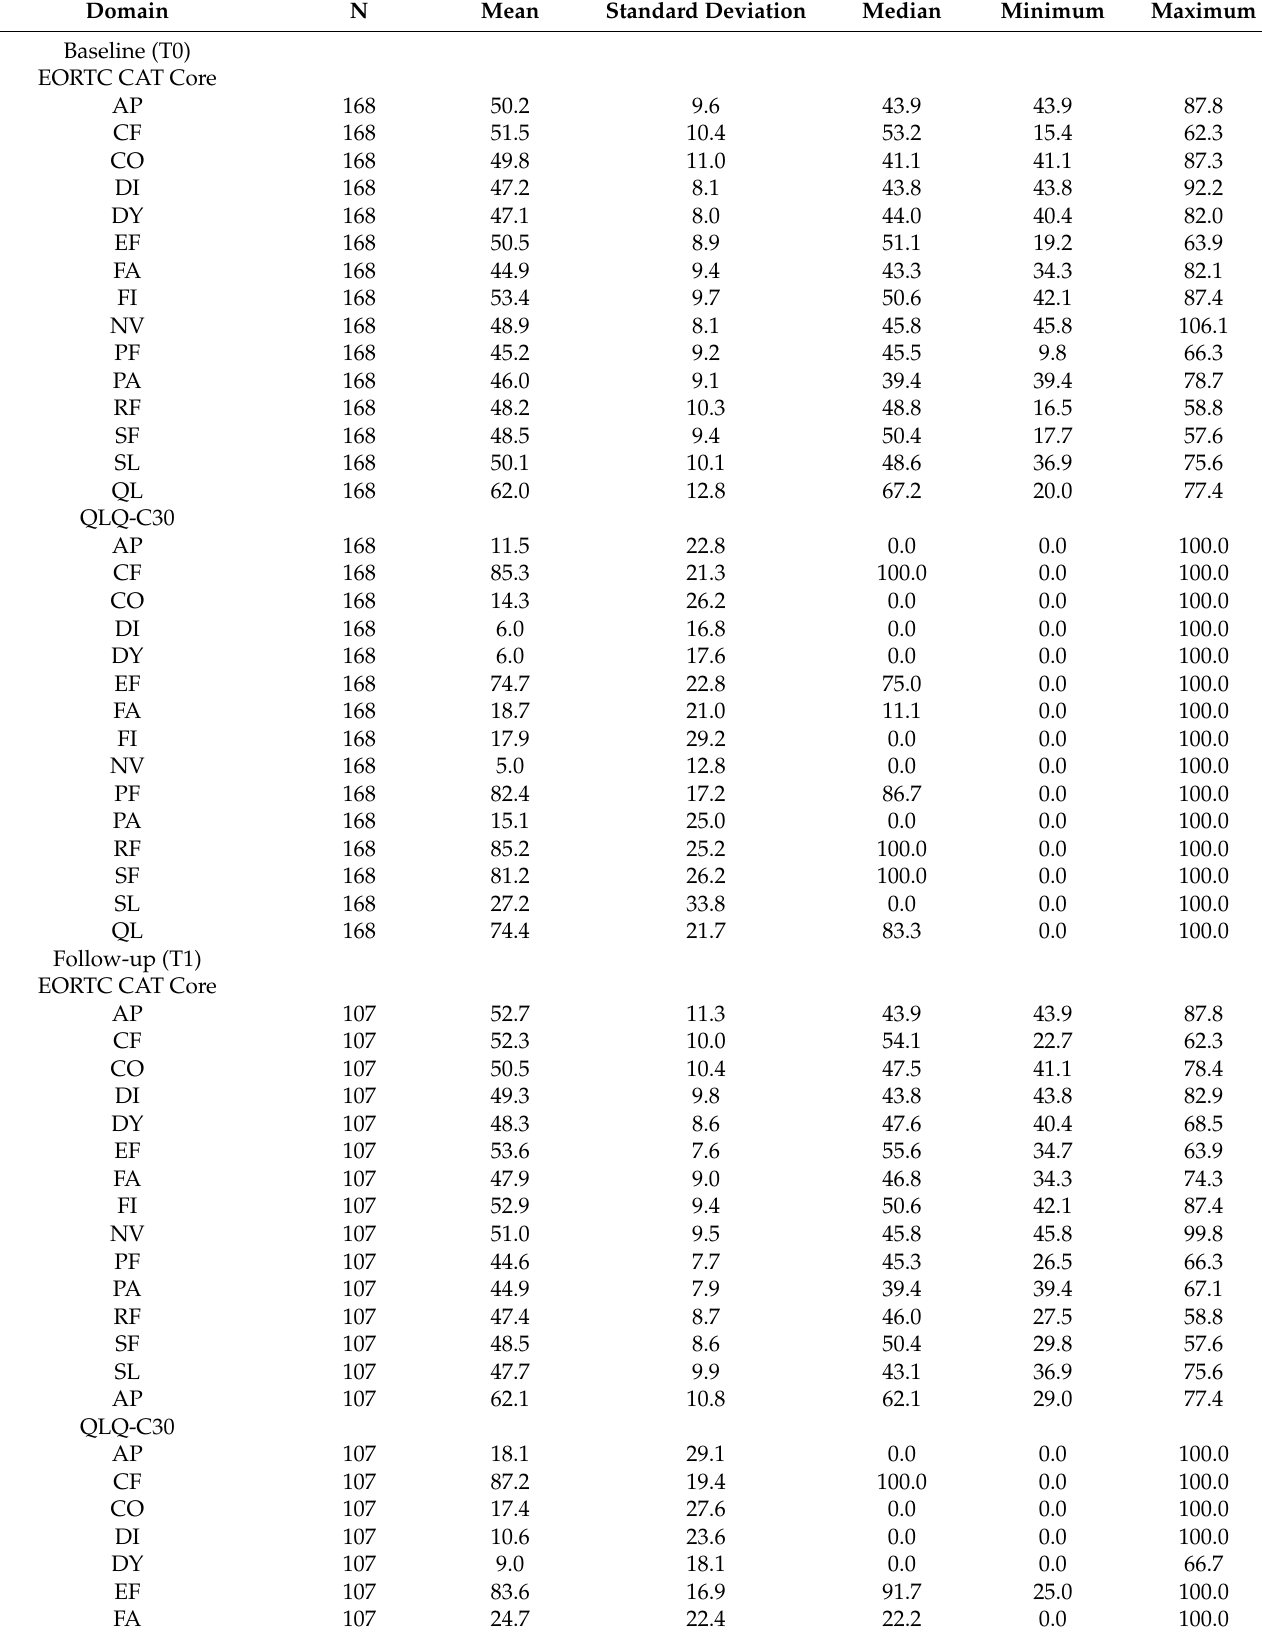
Table 1. Brazilian data. The EORTC CAT Core and QLQ-C30 scores at baseline (T0) and follow-up (T1) for Brazilian